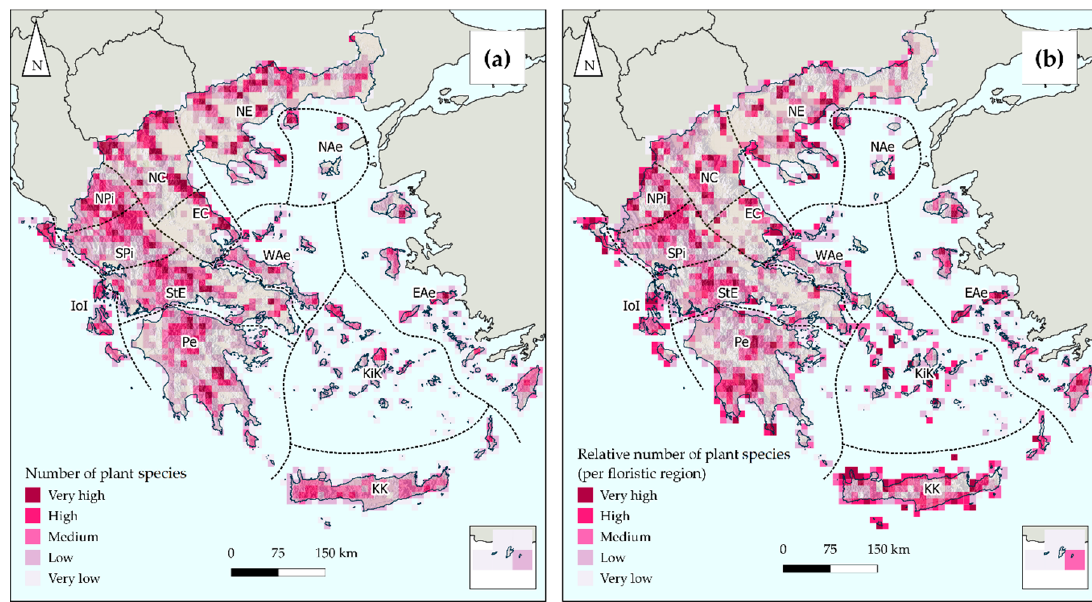
Figure 4. Thematic representation for ‘woodland and forest’ ecosystem type species richness at the 10 × 10 EEA reference grid level: ( a ) Number of species present in woodland and forest per cell; ( b ) relative number of species present in woodland and forest per cell, i.e., number of plant species present in woodland and forest per cell divided by the number of plant species present in woodland and forest in each floristic region (normalized). Floristic regions of Greece [40,42] are also depicted: East Aegean islands (EAe), East Central Greece (EC), Ionian Islands (IoI), Kriti and Karpathos (KK), Kiklades (KiK), North Aegean islands (NAe), North Pindos (NPi), North Central Greece (NC), North-East Greece (NE), Peloponnisos (Pe), South Pindos (SPi), Sterea Ellas (StE), West Aegean islands, (WAe).